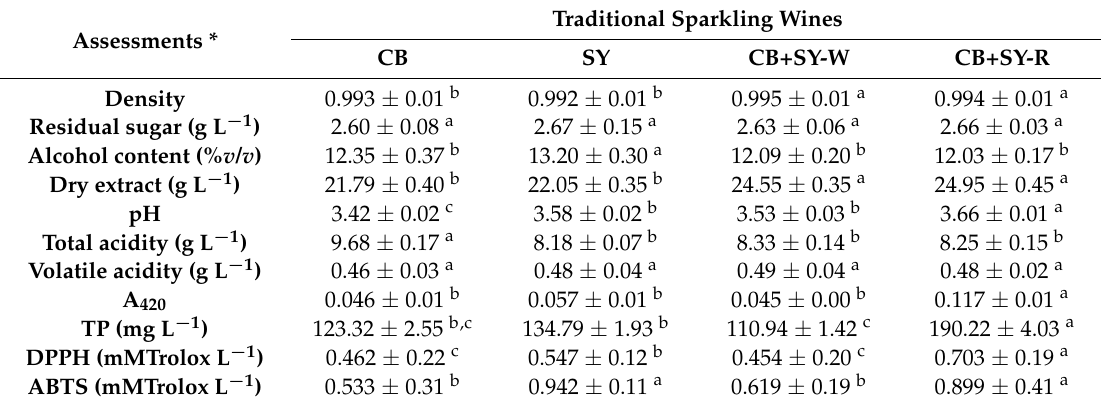
Table 1. Classical analyses, spectrophotometric and antioxidant activity of the sparkling wines elaborated by the traditional method in the